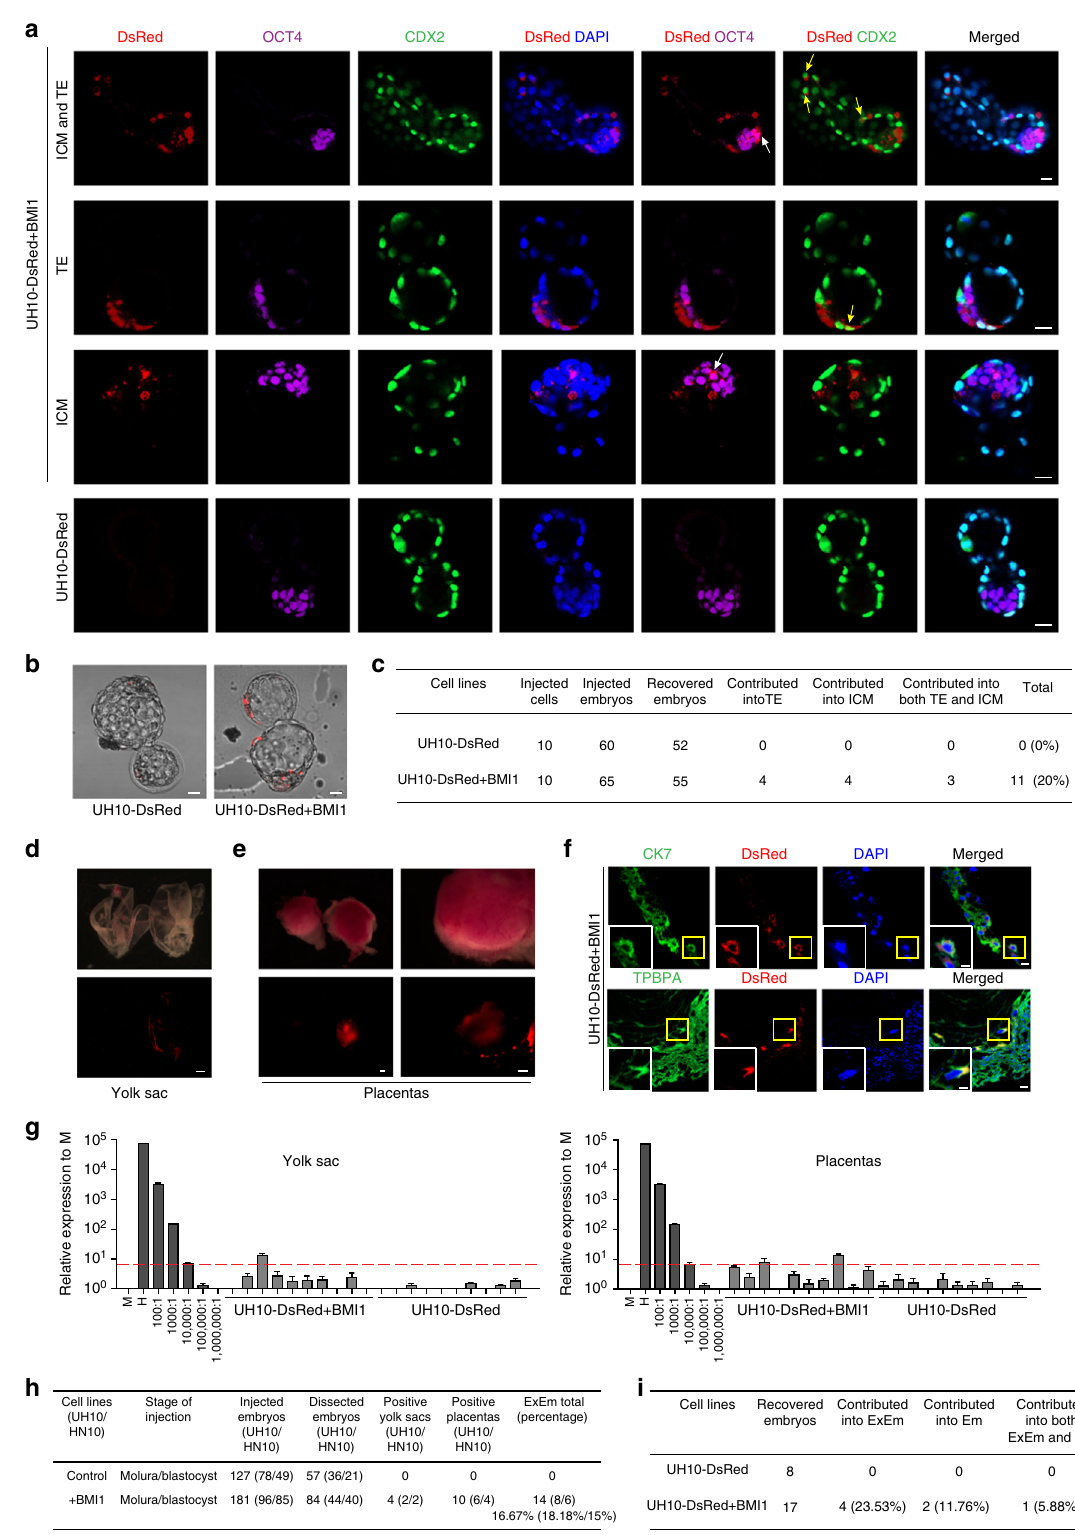
theoretically pluripotent as they could form teratomas con- sisting of three typical embryonic germ layers 11 as well as differentiate into trophoblast in vitro 34,35 . Therefore, the conventional hPSCs might in theory hold the potential to differentiate in host embryos if they could integrate and survive well in preimplantation morulas or blastocysts.